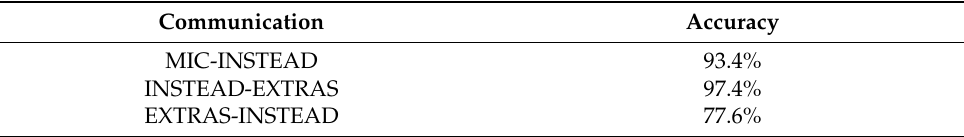
Table 7. Results of INSTEAD, MIC and EXTRAS